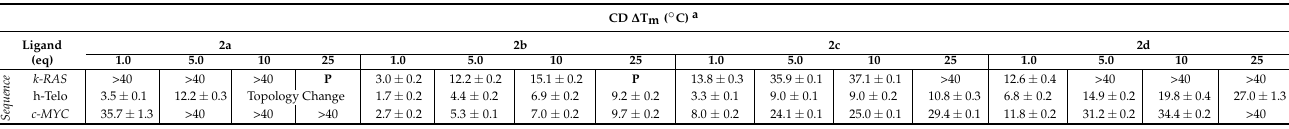
Table 3. Melting temperature variations ( ∆ T m ) values for the tested sequences in the presence of the methylated dicarbox- amide derivatives, obtained by CD-melting